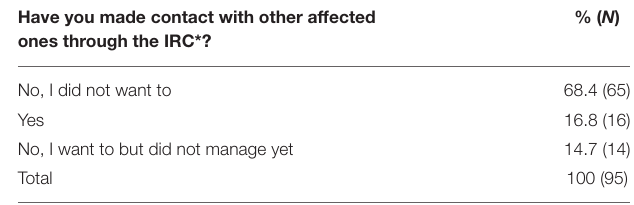
TABLE 2I | Survey results of affected ones (data source A), N =